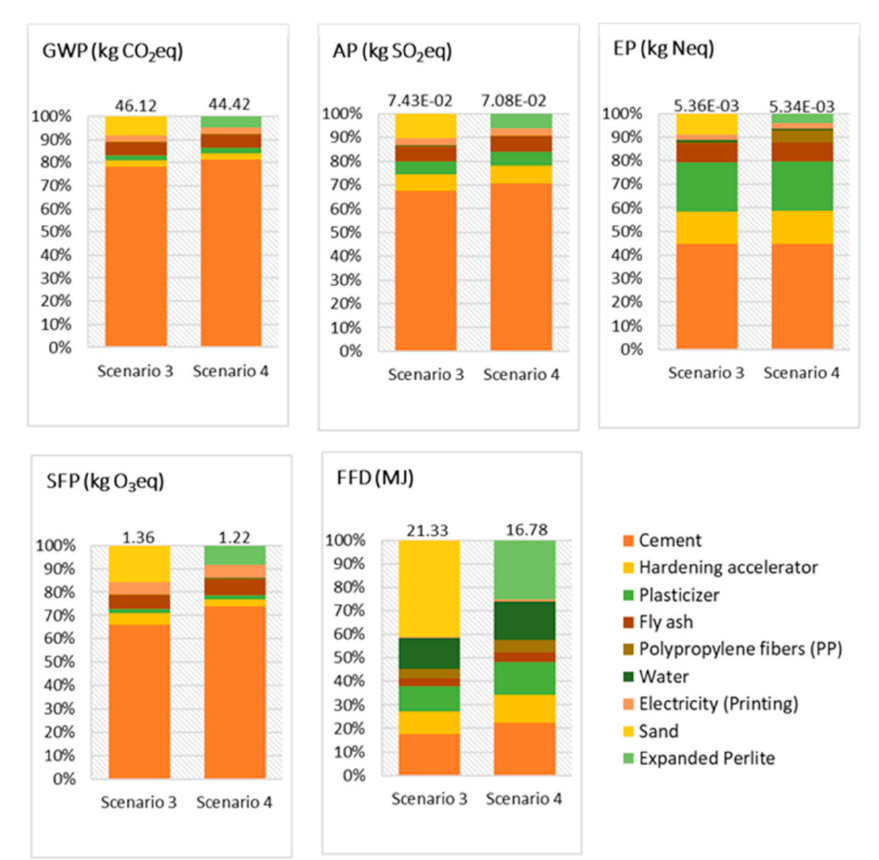
Figure 10. Breakdown of environmental impact per material for S-3 and S-4.